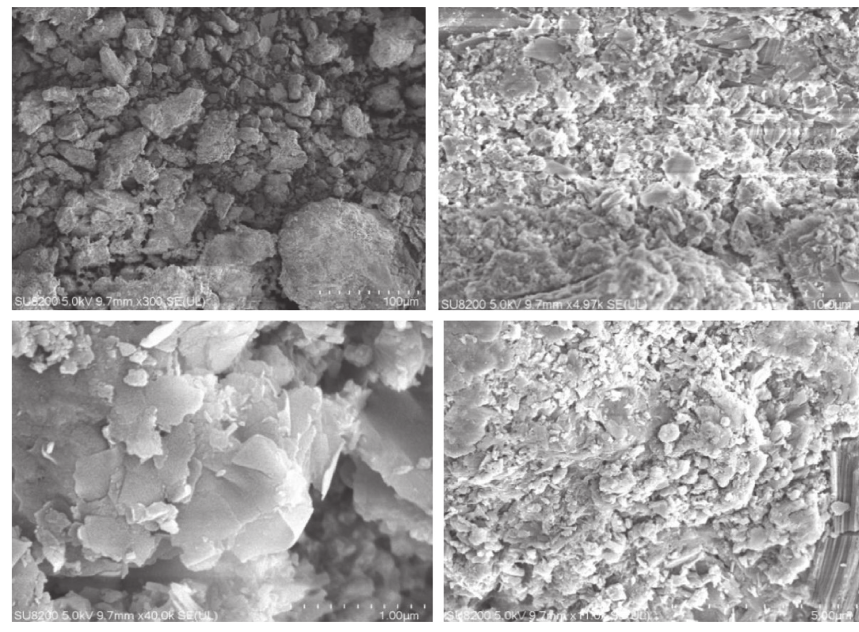
Figure 6: Microstructure of Group 4.